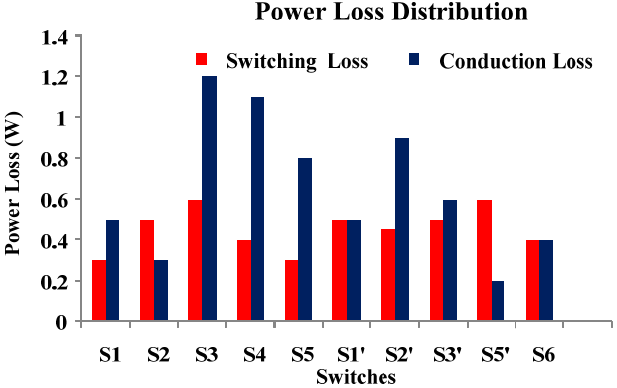
Figure 16. Power loss breakup.